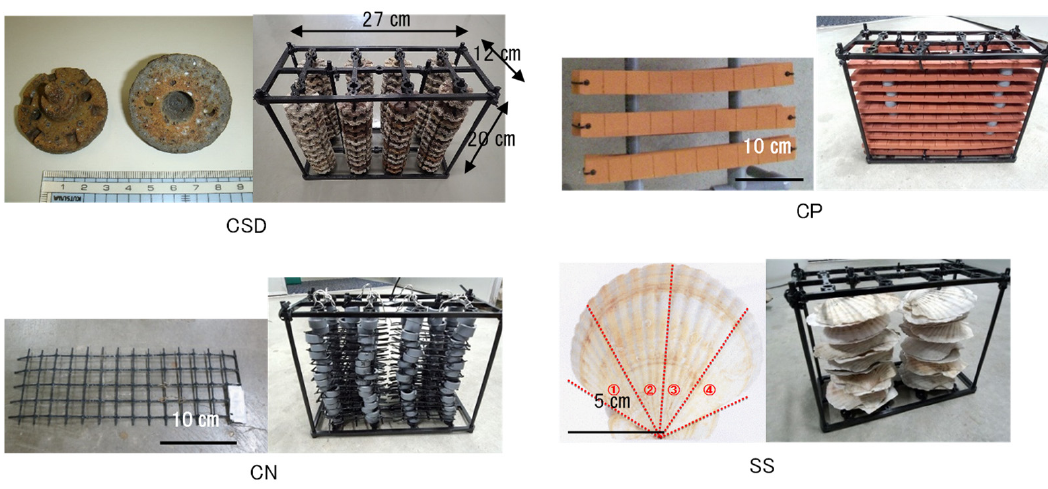
Figure 1. Four types of substrates with different structures used for the study. Individual substratum shown on left side was combined into a set on right side.